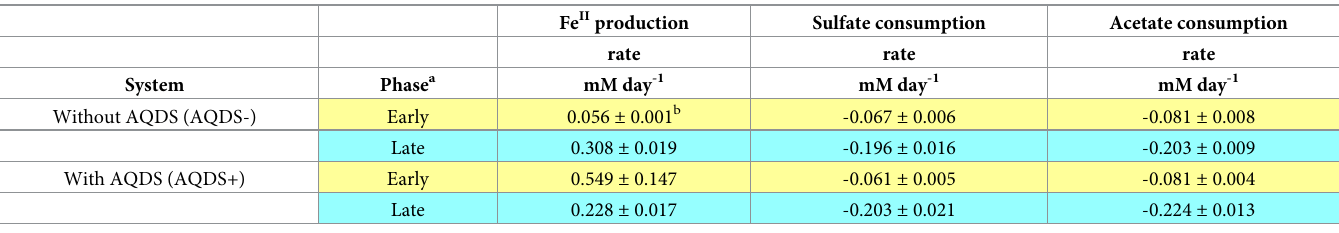
Table 1. Rates of Fe II production and sulfate and acetate